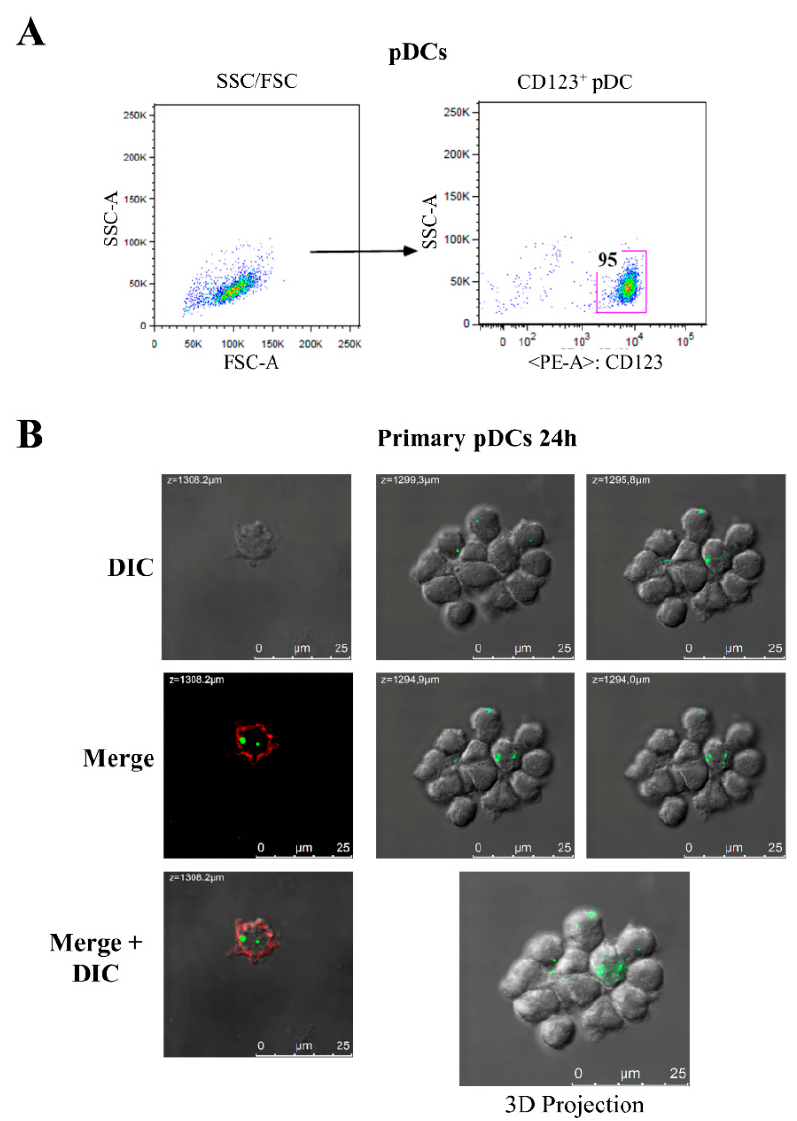
Figure 2. Internalization of Nef protein in plasmacytoid dendritic cells. ( A ) Flow cytometry plots showing the forward light scatter/SSC profile of the cells. Purity of pDCs was determined by staining cells with anti-CD123 antibodies. ( B ) Primary pDCs were seeded at 10 5 cells/200 µ L in 96-well plates. Purified pDCs were treated with 300 ng/mL of myrNef SF2 conjugated with AlexaFluor488 (green) for 24 h. Afterwards, cells were fixed, as reported in Materials and Methods, and analysed by confocal microscope (Leica TCS SP5), software LAS AF version 1.6.3 (Leica Microsystems). Plasma membrane counterstaining was performed using PKH26-GL (red). Objective 63.0X. DIC: Differential Interference Contrast Images. Scale bars 0–25 µ m. Representative images of two independent experiments are shown.